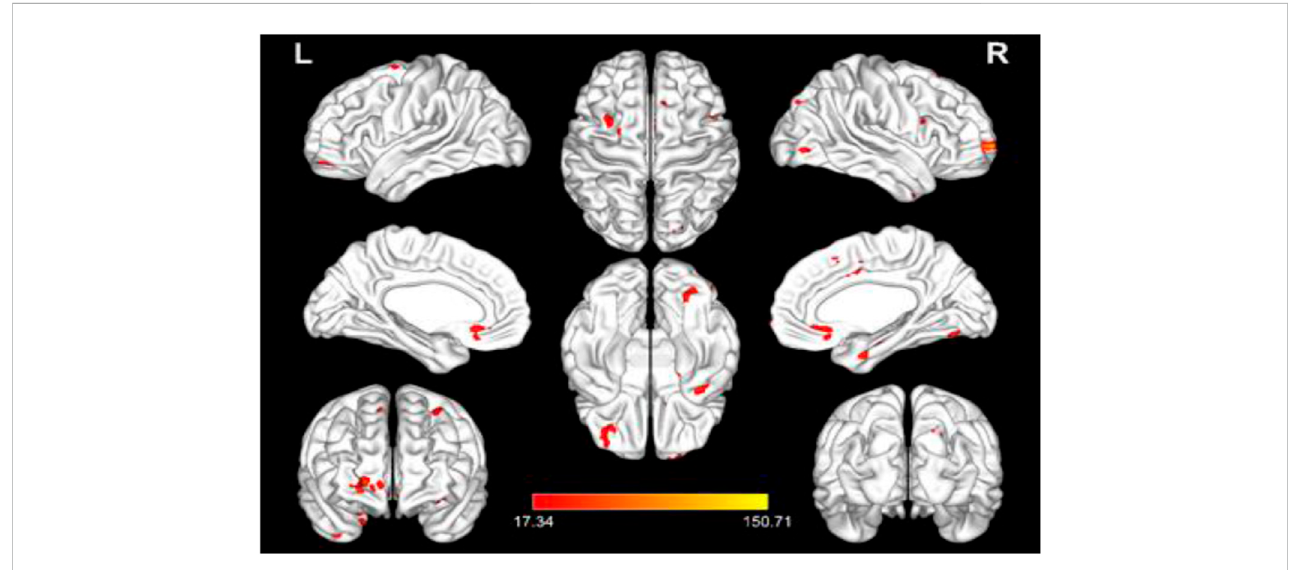
FIGURE 1 3D plot of the signi fi cant interaction of fALFF values. Note: The red bars represent those brain regions with signi fi cant interactions, and the statistical threshold was set to p < 0.001 and the number of voxels was > 20. L: left; R: right; and fALFF: low-frequency amplitude